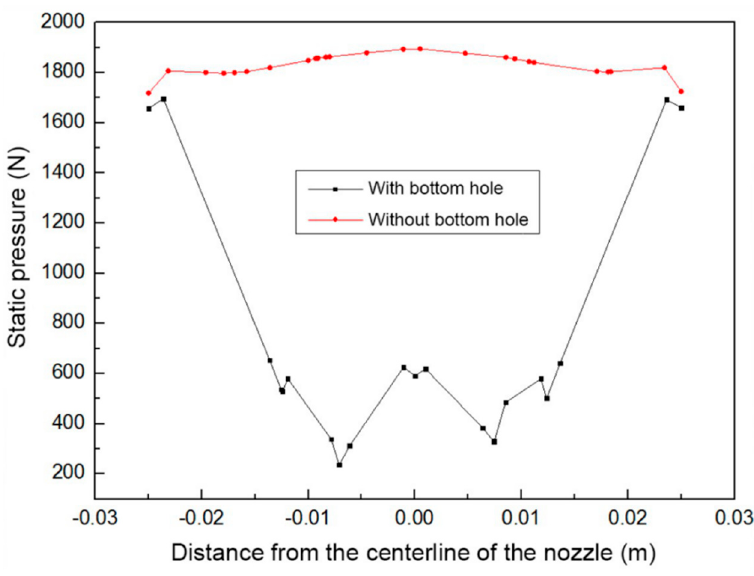
Figure 12. Variation of pressure at different bottoms of a submerged nozzle.